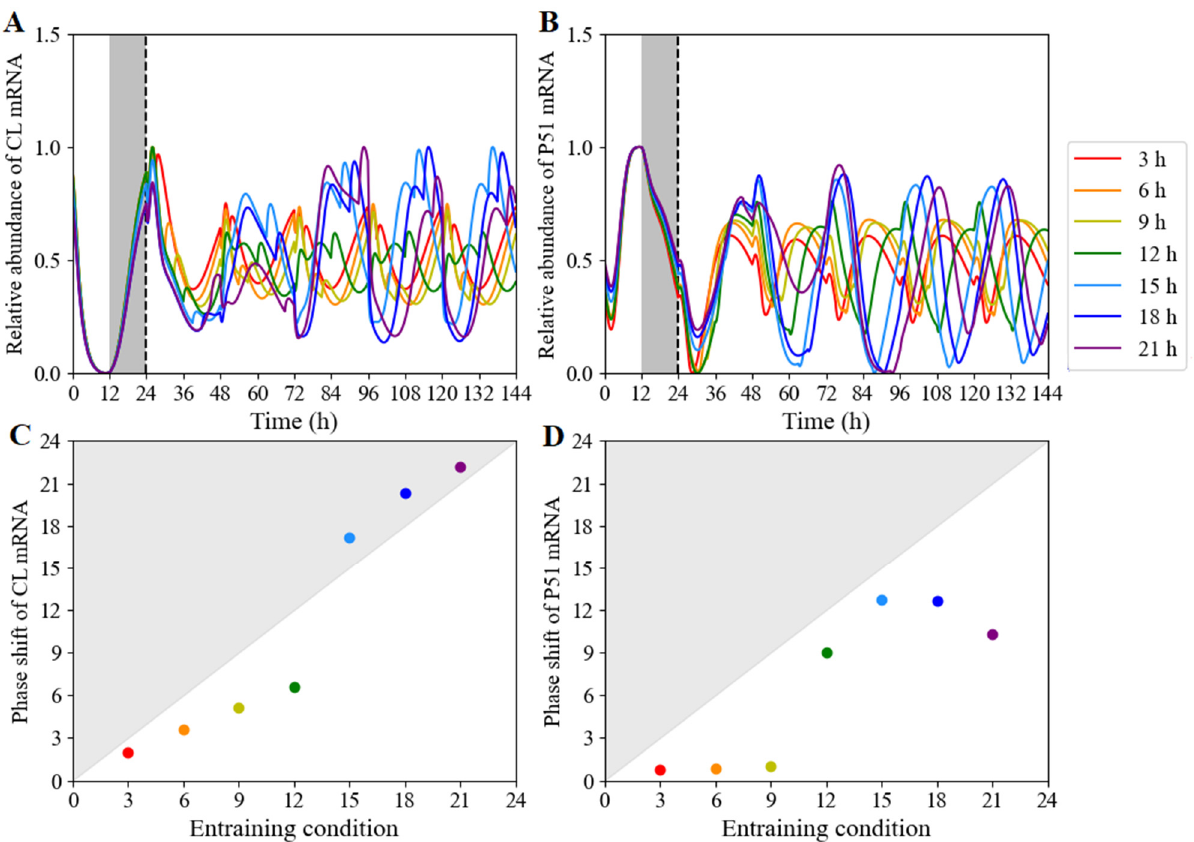
Figure 8. CCA1 / LHY and PRR5 / TOC1 expression profiles and phase shifts under different red- light/dark photoperiods. ( A , B ) The time courses of respective CL ( CCA1 / LHY ) and P51 ( PRR5 / TOC1 ) transcription levels under red-light photoperiods ranging from 3 to 21 h at intervals of 3 h. The system had been entrained to 12 h white-light/12 h dark cycles for 5 days, transferring into red light. ( C , D ) The corresponding phase shifts of CL (CCA1/LHY) and P51 (PRR5/TOC1), respectively. The grey and white bars represent darkness and red-light treatment,